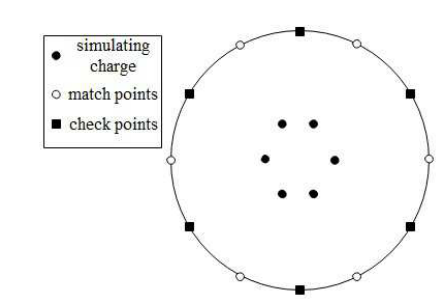
Figure 4. Distribution of the simulating charges, match points, and check